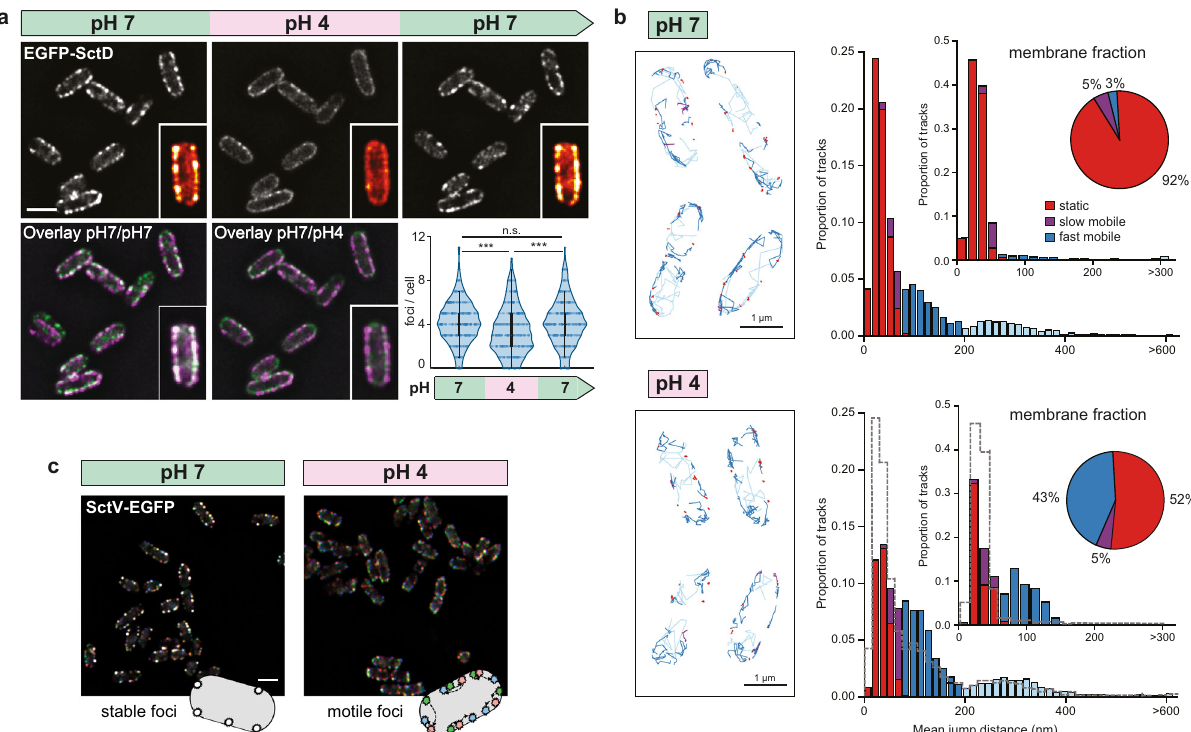
Fig. 5 The bitopic IM protein SctD reacts to low external pH. a Fluorescent micrographs of EGFP-SctD in live Y. enterocolitica , consecutively subjected to different external pH in a fl ow cell. Images were taken under secreting conditions, 10 min after bacteria were subjected to the indicated pH. Insets, enlarged single bacteria, visualized with the ImageJ red-hot color scale. Bottom, overlays of fl uorescence at pH 7 before pH change (magenta) and pH 7 after pH change or pH 4 (green). Bottom right, quanti fi cation of foci per bacterium. n = 468 cells from three independent biological replicates. White circle denotes median, black bar denotes fi rst and third quartile, black line denotes the lower/upper adjacent value. *** p < 0.001 in homoscedastic two-tailed t -tests; n.s., difference not statistically signi fi cant ( p ~ 2 × 10 − 11 , 2 × 10 − 8 , 0.42 for pH 7/4, pH 4/7 and pH 7/7, respectively). b PAmCherry-SctD dynamics in exemplary living Y. enterocolitica (left) and histograms (right) of the mean jump distances (MJD) of PAmCherry-SctD trajectories weighted by the number of jump distances used for calculating each MJD. Only trajectories with more than 6 one-frame jumps are shown and included into the analysis. Upper panel was measured at pH 7, lower panel at pH 4. Trajectories are assigned into two diffusive states: static (red) and mobile (violet and blue fractions) based on the experimental localization precision. Mobile trajectories are sorted into three MJD categories: lower than 60 nm (violet), lower than 195 nm (dark blue) and higher than 195 nm (light blue). Counts were normalized to the total number of trajectories. At pH 7 we acquired 29,859 trajectories (60%